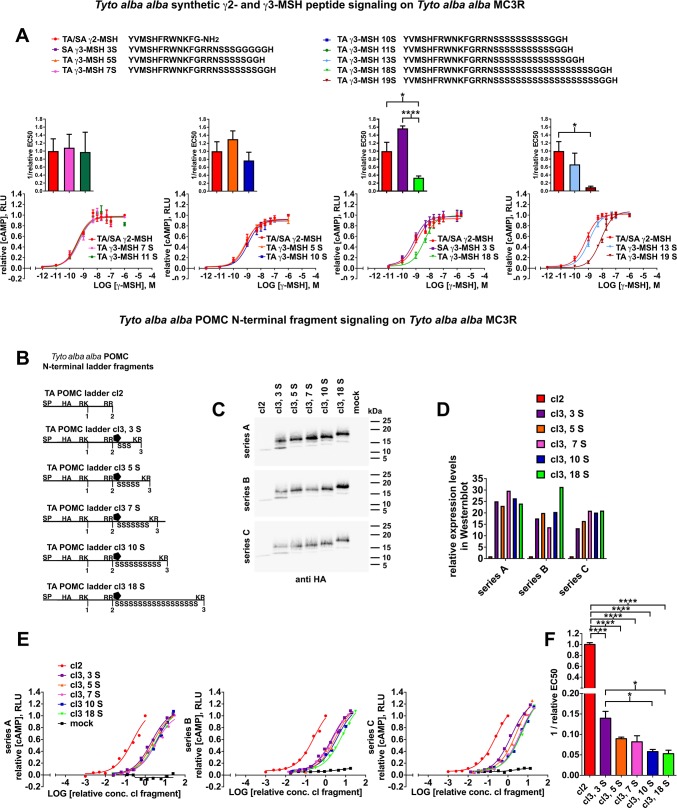
The signaling activity of N-glycosylated γ3-MSH on MC3R is reduced compared to γ2-MSH.(A) Receptor signaling of synthetic, non-glycosylated γ2- and γ3-MSH peptides (aa sequences depicted at the top). HEK293T cells were transiently transfected with expression plasmids for the TA MC3R and Glo-sensor. After 26 h, cells were exposed to the indicated synthetic peptides at the given concentrations. Dose-response curves were established by non-linear regression curve fit and normalized to the signaling activity of γ2-MSH at 1 μM. The relative signaling activities of γ3- compared to γ2-MSH were calculated from normalized dose response curves (highest value = 1, lowest value = 0) and expressed as 1 / relative EC50 (n = 3 dose response curves per peptide, statistical differences were determined by unpaired t-test, *p < 0.05, **p<0.01, ***p<0.001, ****p<0.0001). (B) Schematic representation of recombinant N-terminal TA POMC cleavage site 2 and 3 fragments including from N- to C-terminus: the POMC signal peptide (SP), the HA epitope-tag, the mature N-terminal POMC sequence up to cleavage site 2 (cl2) or cleavage site 3 (cl3), with 3, 5, 7, 10 or 18 serine residues in the γ3-MSH locus. (C) The constructs in B were transiently expressed in HEK293T cells and detected in supernatants by Western blot 71 h post transfection (triplicates). Please note the presence of characteristic upper bands corresponding to N-glycosylated forms (compare with S4 Fig). (D) Densitometric quantification of C. (E) Supernatants from transfected cells were serially diluted and signaling activity on TA MC3R assessed by Glo-sensor assay as in 5A. Relative concentrations were corrected for the expression levels in cell supernatants (C, D) and maximal luminescence values normalized in each transfection series to the maximal signaling activity of TA POMC cl2 fragment at its highest concentration. Dose-response curves were established (E). Supernatants from mock-transfected cells served as negative controls (mock). (F) Relative EC50 values for the different N-terminal TA POMC cl2 and cl3 fragments were calculated from dose response curves in E (n = 3), and the signaling activity (1 / relative EC50) was determined and normalized to 1 / relative EC50 of TA POMC cl2 fragment from the same transfection series. Mean values and SEM are depicted (n = 3). Differences were evaluated by ANOVA followed by Tukey’s multiple comparison test (*p<0.05, **p<0.01, ***p<0.001, ****p<0.0001).